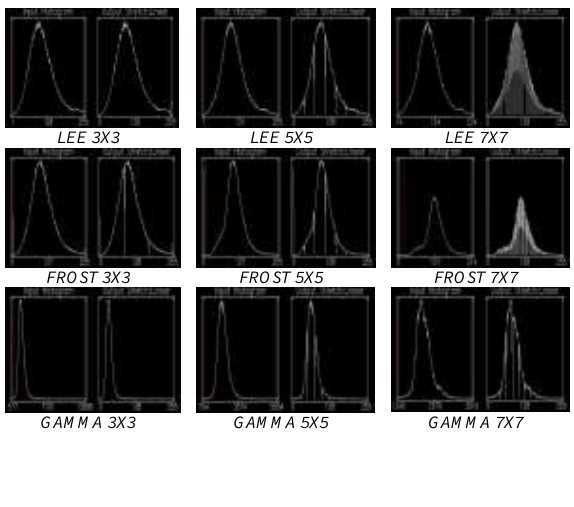
Figure 4 : Histogram for different filtering techniques in various window sizes tested for Lembah Bujang